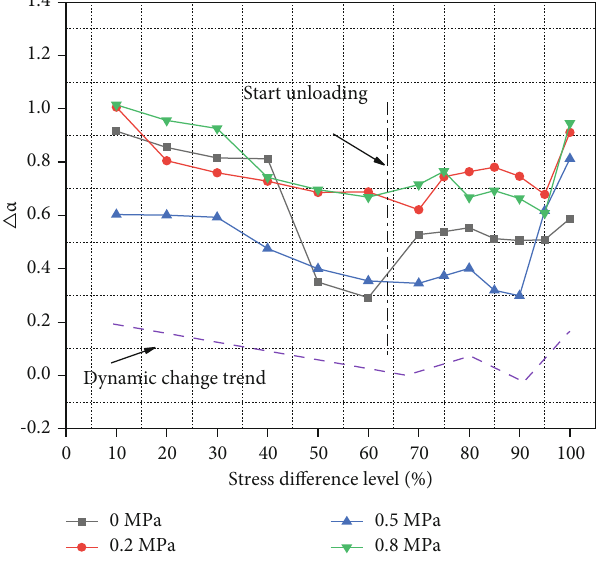
Figure 9: Di ff erent stress levels Δα